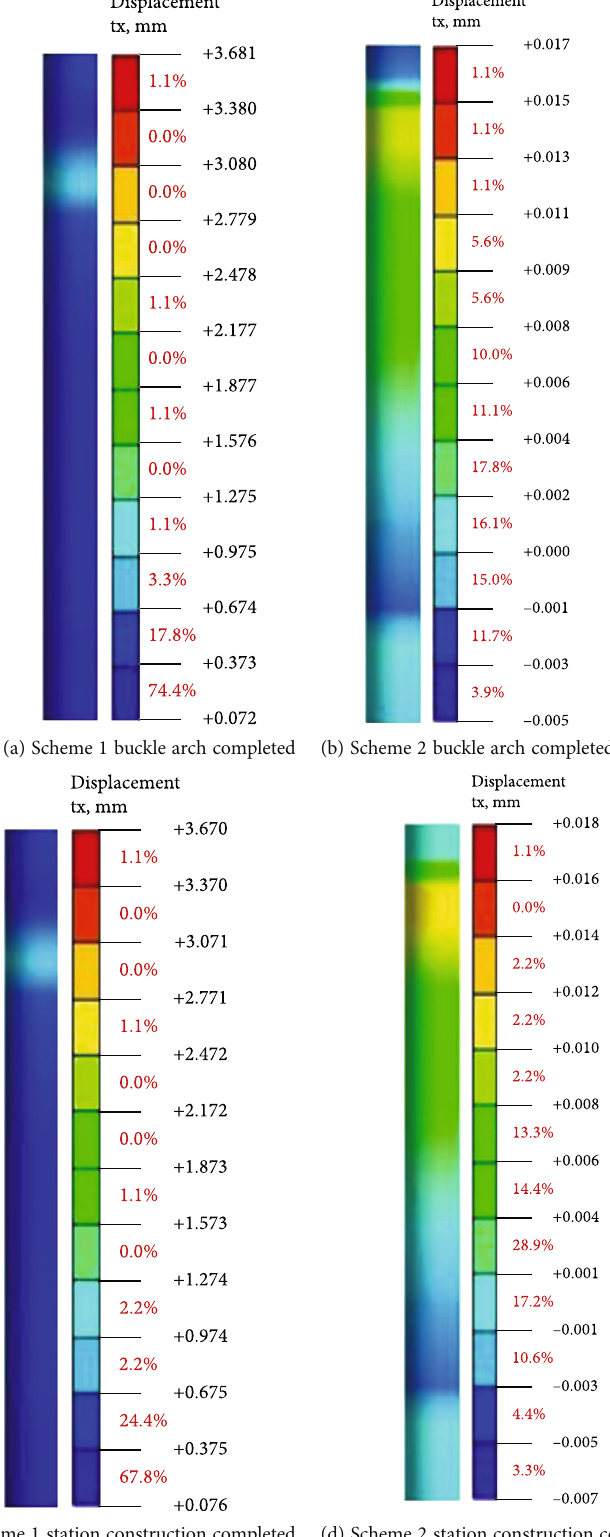
Figure 14: Contrast cloud diagram of the lateral displacement of the middle column in schemes 1 and